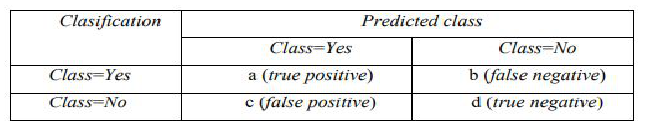
Table 2. Confusion Matrix 2 class